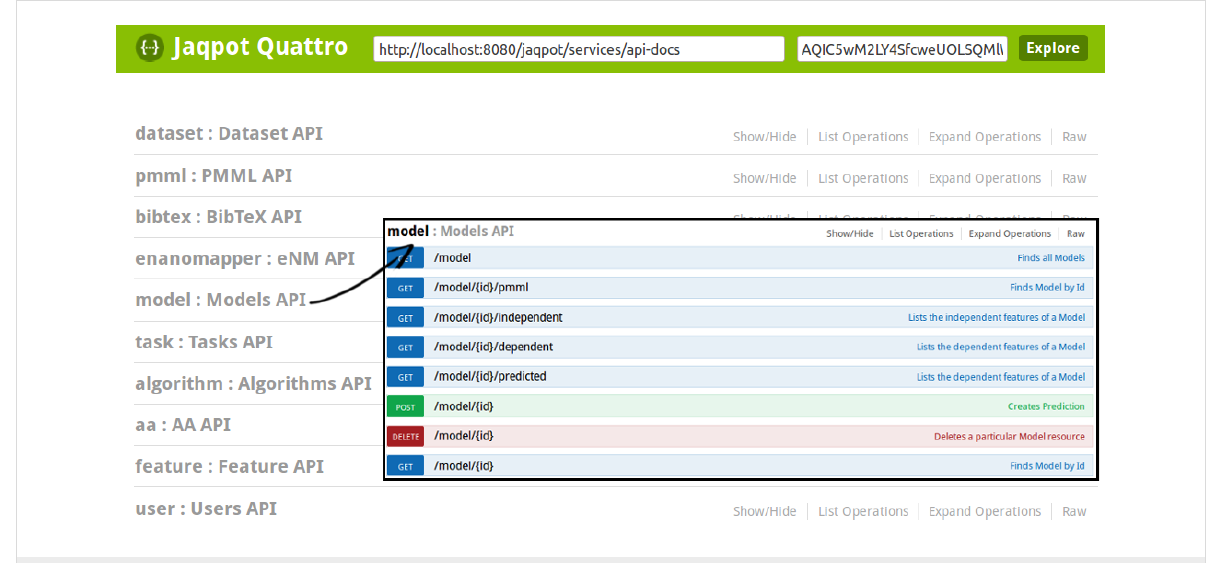
Figure 19: Screenshot of the Jaqpot Quattro modelling web services API, compatible with the eNanoMapper API. A list of REST endpoints is presented to the end user. These correspond to the main entities/resources of eNanoMapper: datasets, models, algorithms, BibTeX entities, asyn- chronous tasks and more. The user can click on any of these to get a list of the available operations related to each entity. In the inset of this figure we see the list of model-related operations. For more information consult the OpenTox Model API